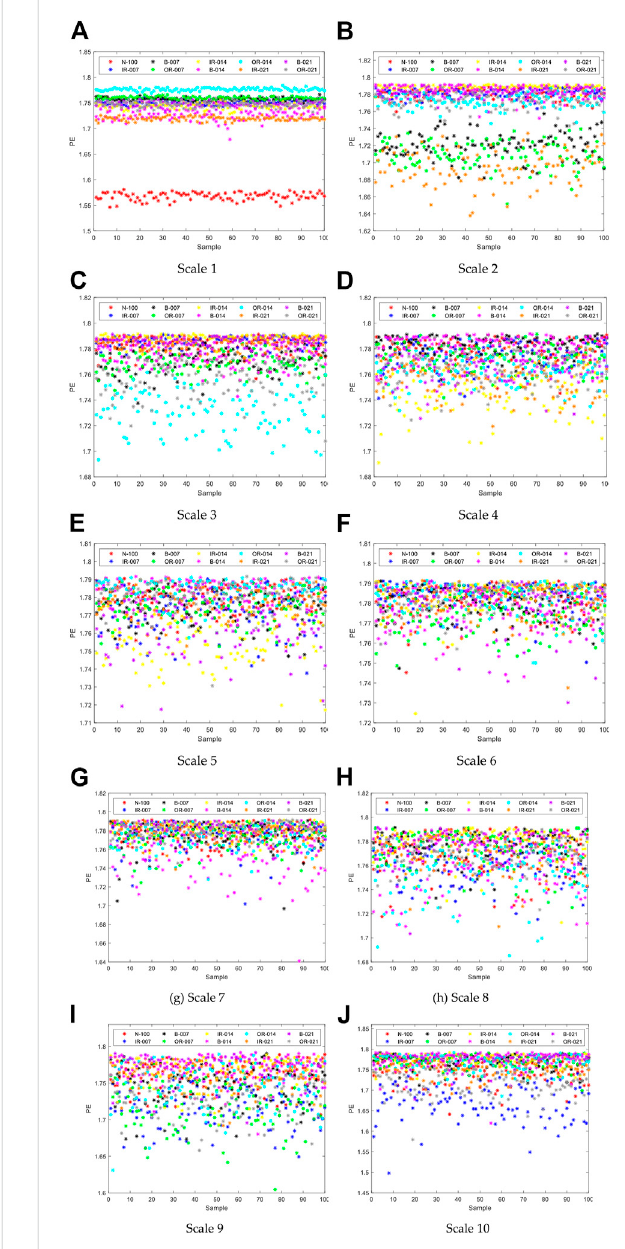
FIGURE 4 Singlefeaturedistributionoftenscales ofMPEfor tensignals: (A- J) represent Scale 1 to